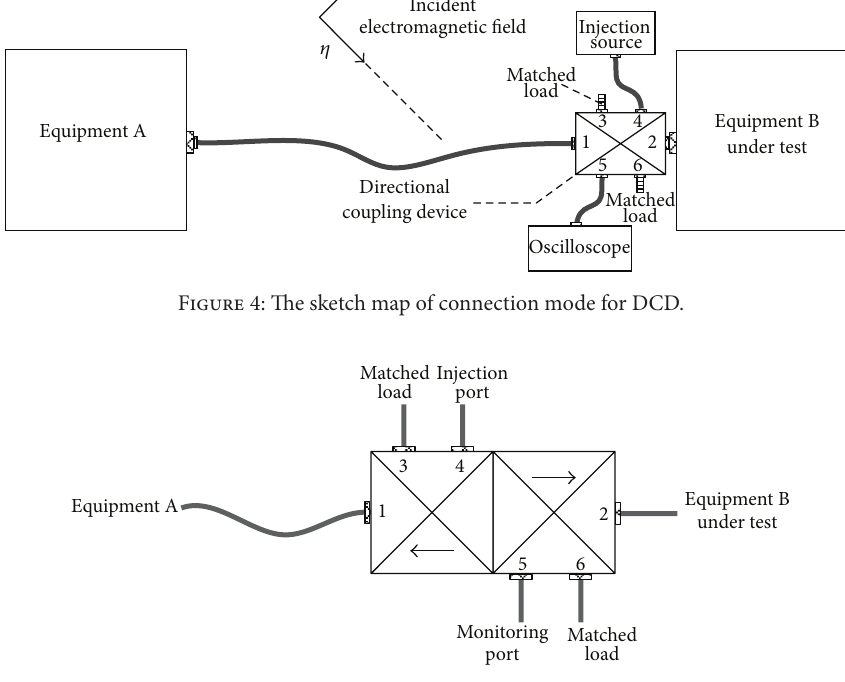
Figure 5: The function and structure of the